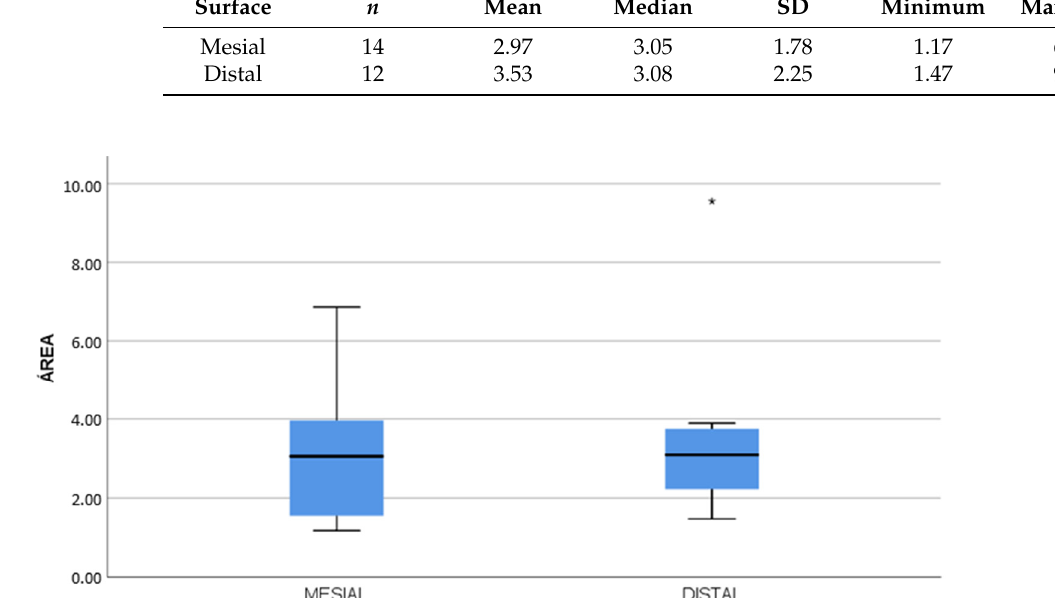
Figure 8. Box plot of the area of the enamel removed after the interproximal enamel reduction procedure at the mesial and distal interproximal enamel surfaces of the STL digital files. “*” represent an outlier.